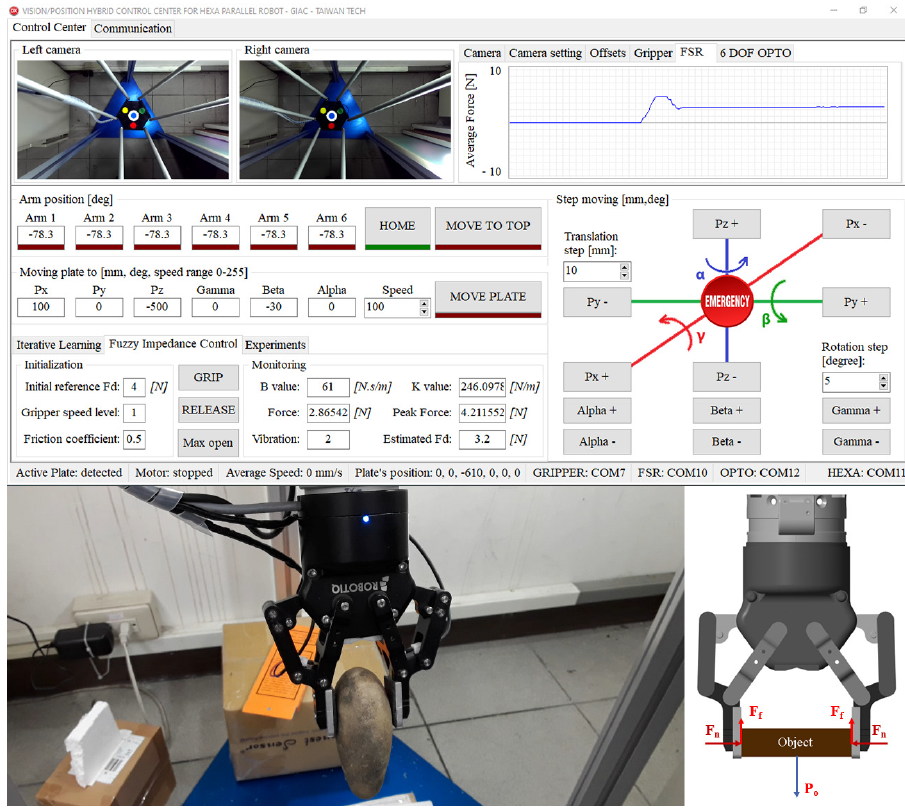
Figure 5. The two-finger gripper and control software interface.